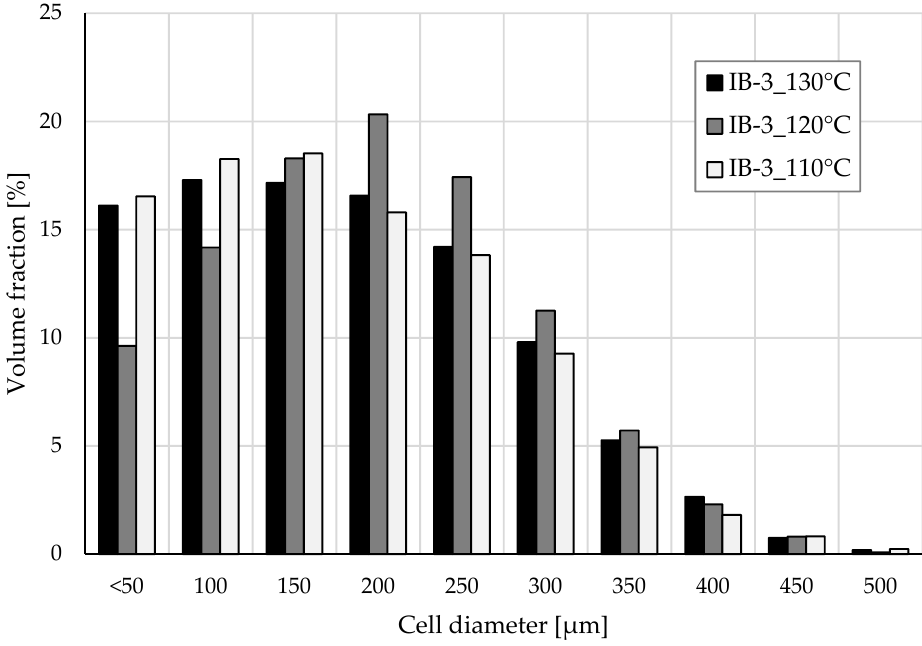
Figure 8. Cell size distribution of selected samples determined with XµCT. Table 4. The densities of prepared cellulose palmitate foams using different foaming temperatures and 3% IB as a blowing agent.